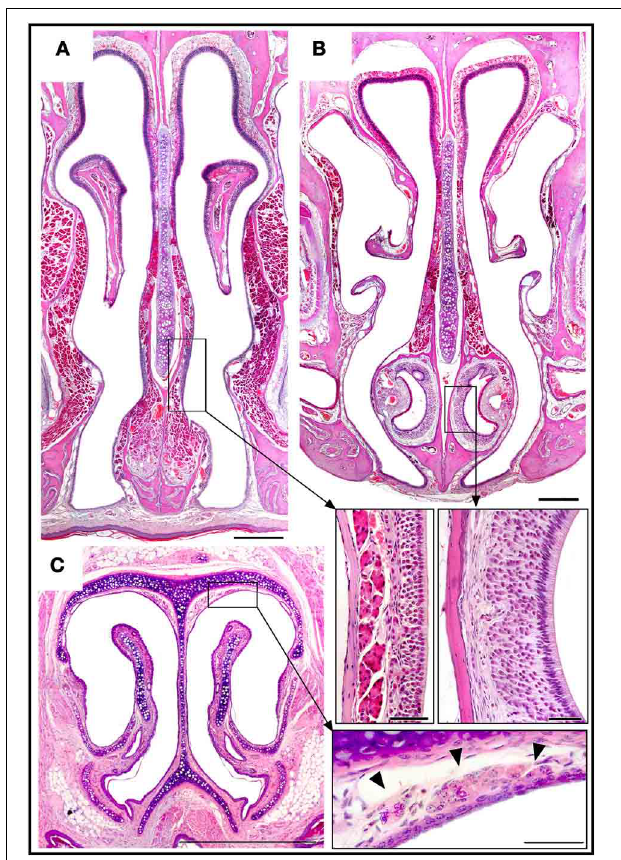
FIGURE 6 | Haematoxylin-eosin-stained transverse sections showing the locations of the septal organ (A), the vomeronasal organ (B), and Grüneberg’s ganglion (C), together with an enlarged view of each in the corresponding inset. Topography of the rüneberg’s ganglion cells (arrows heads). Scale bars: (A–C) , 500 μ m; insets, 50 μ m.